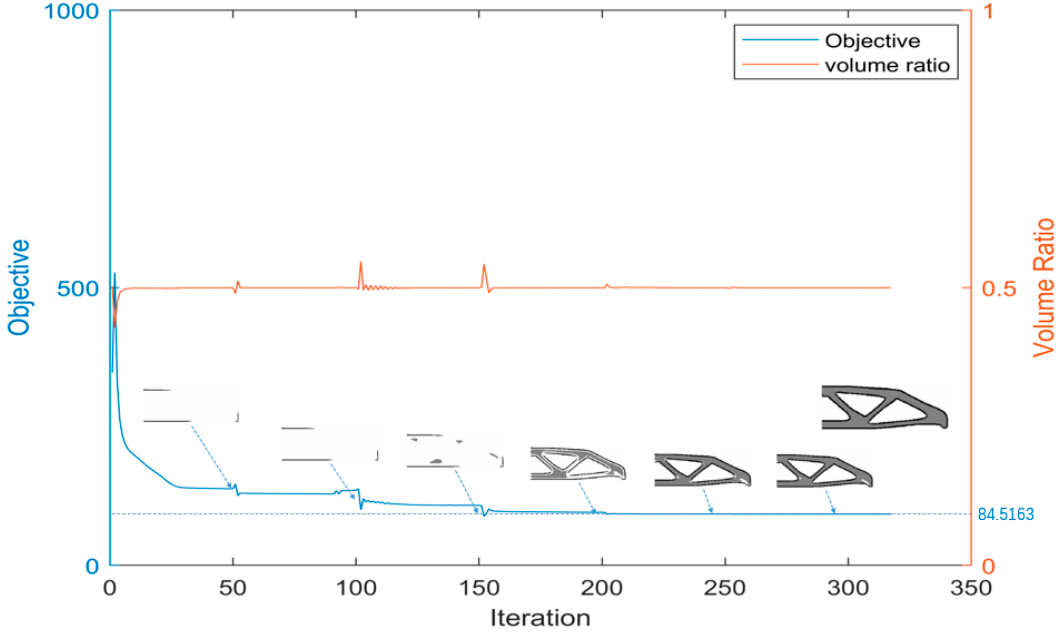
Figure 7. The convergence history.